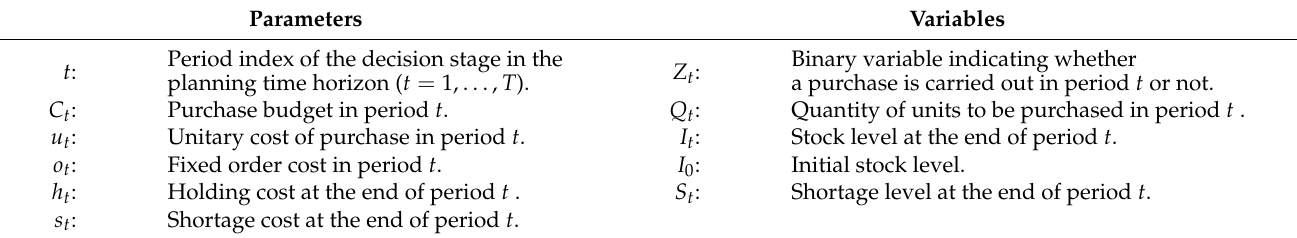
Table 2. Model parameters and decision variables of the lot-size